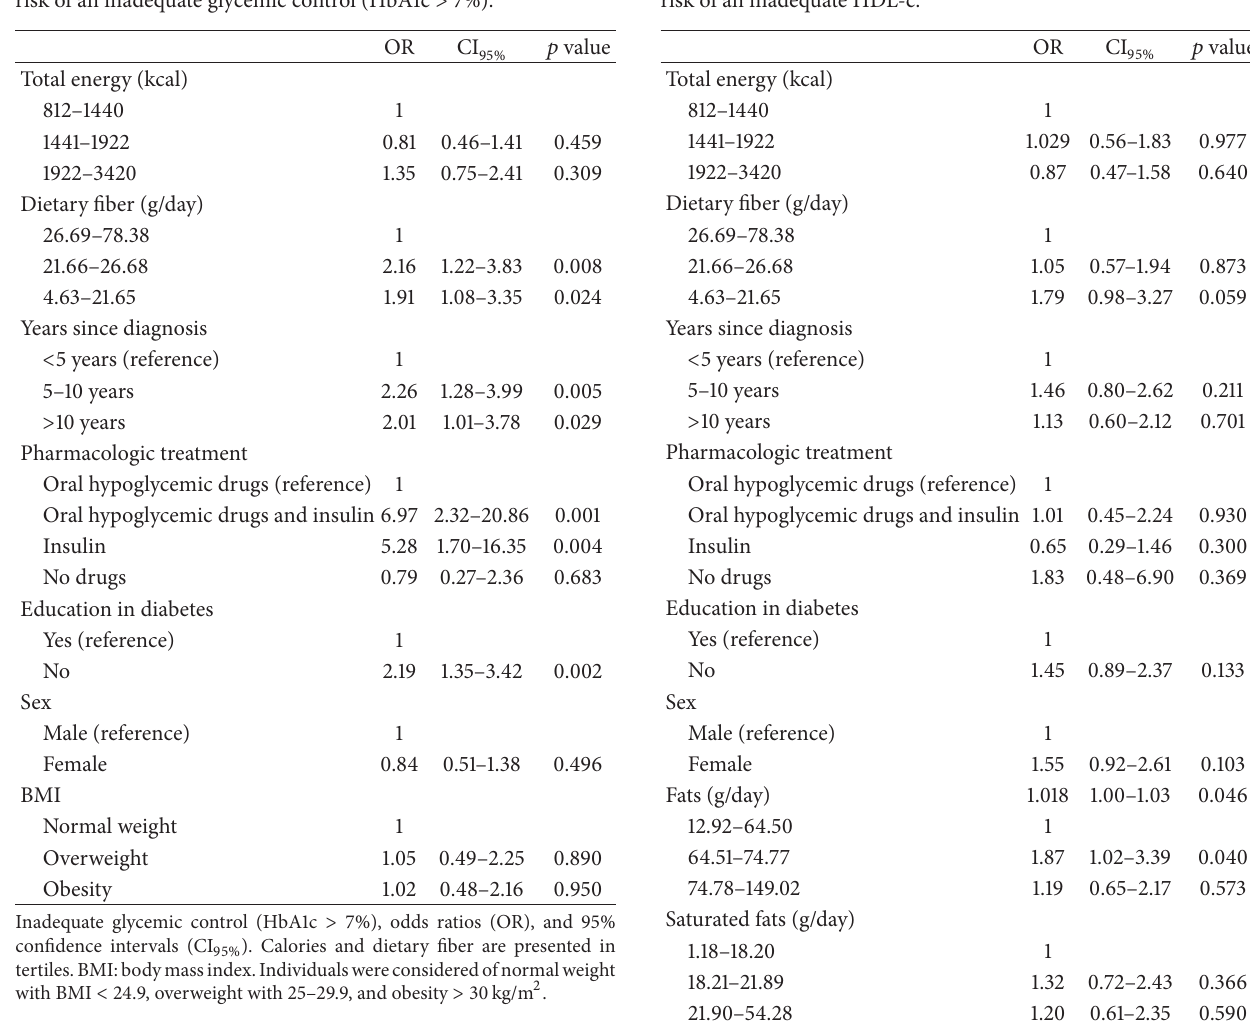
Table 5: Odds ratios (OR) and 95% confidence intervals (CI 95 % ) derived from a multivariate logistic regression model to identify the risk of an inadequate glycemic control (HbA1c > 7%).